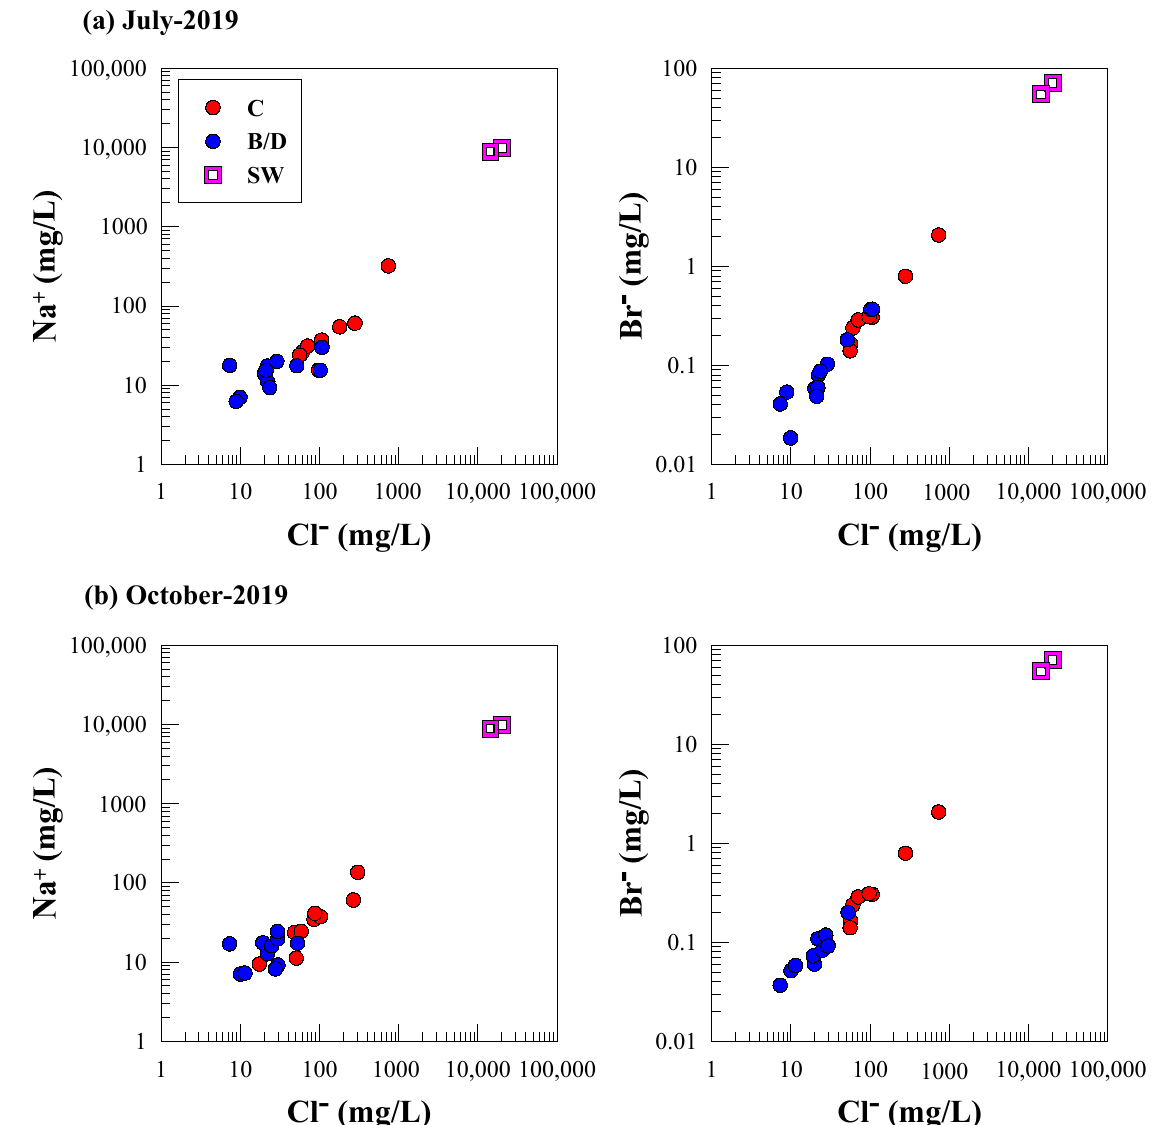
Figure 6. Evaluation of characteristics and sources of groundwater quality by irrigation water influenced by seawater (SW): ( a ) in July 2019 and ( b ) in October 2019. Seawater data were modified from the literature [21].